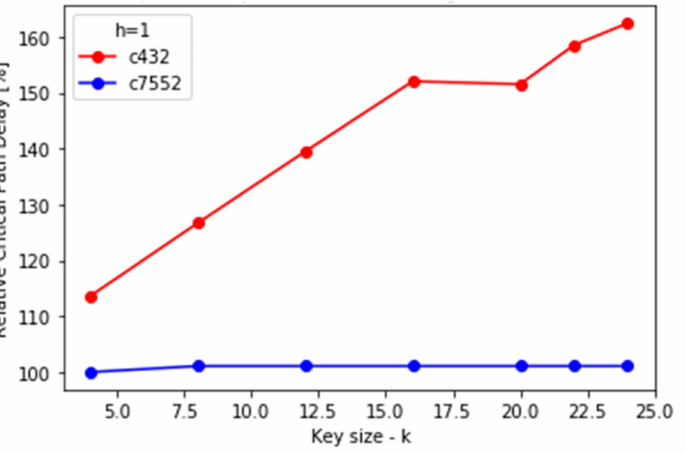
Figure 27. Relative critical path delay increase in locked netlists for different values of key